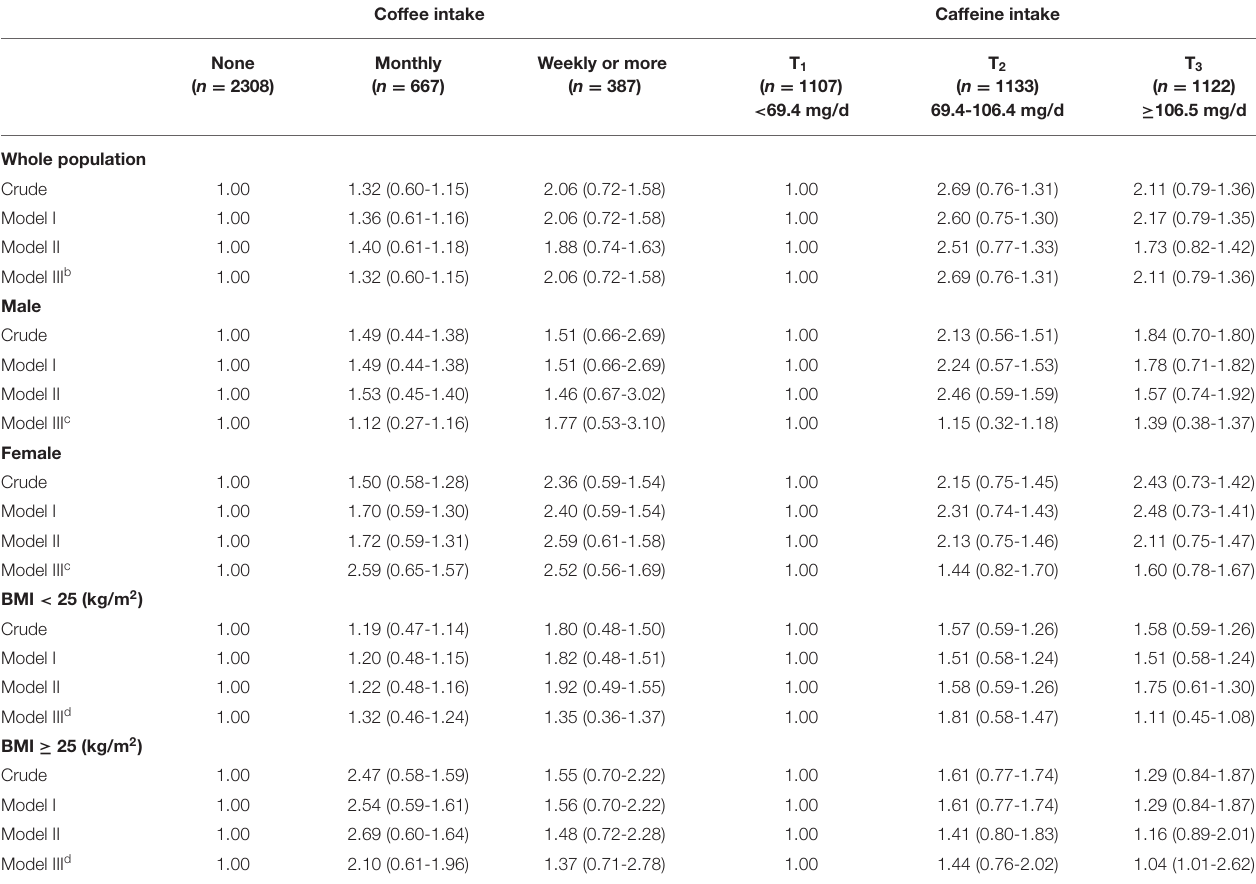
TABLE 3 | Crude and multivariable-adjusted ORs and 95% CIs for IBS severity across categories of coffee and caffeine intake a . Coffee intake Caffeine intake None ( n =